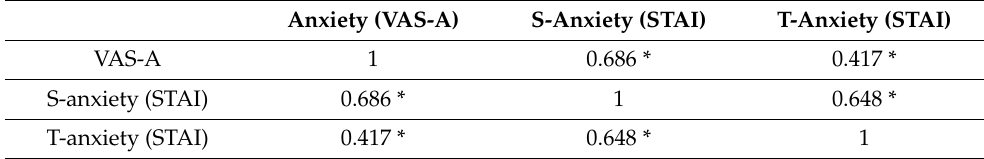
Table 3. Correlation between VAS, S-Anxiety, and T-Anxiety. Anxiety (VAS-A) S-Anxiety (STAI) T-Anxiety (STAI)